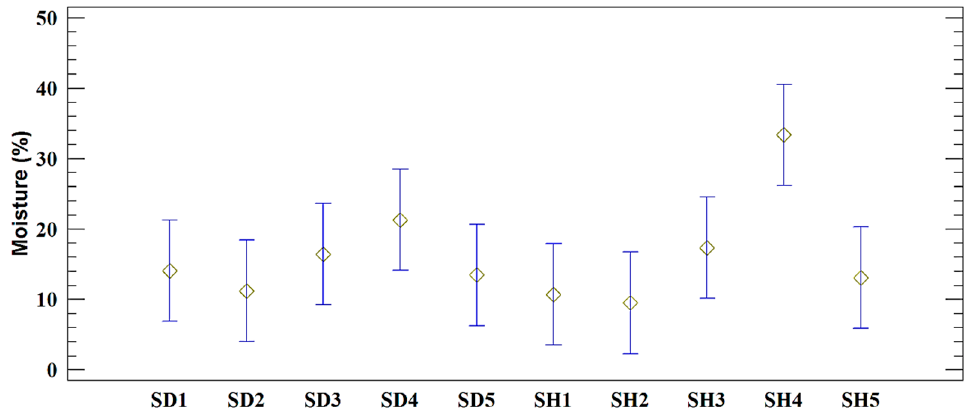
Figure 1. Initial moisture content of the sawdust (SD) and shavings (SH) samples